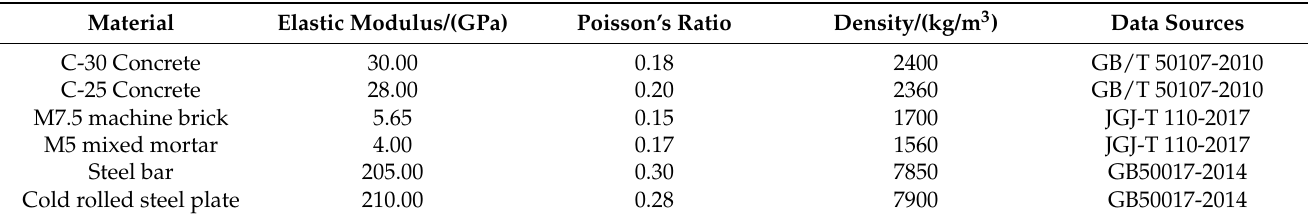
Table 3. Measurement results of the material properties of the Chensilou shaft